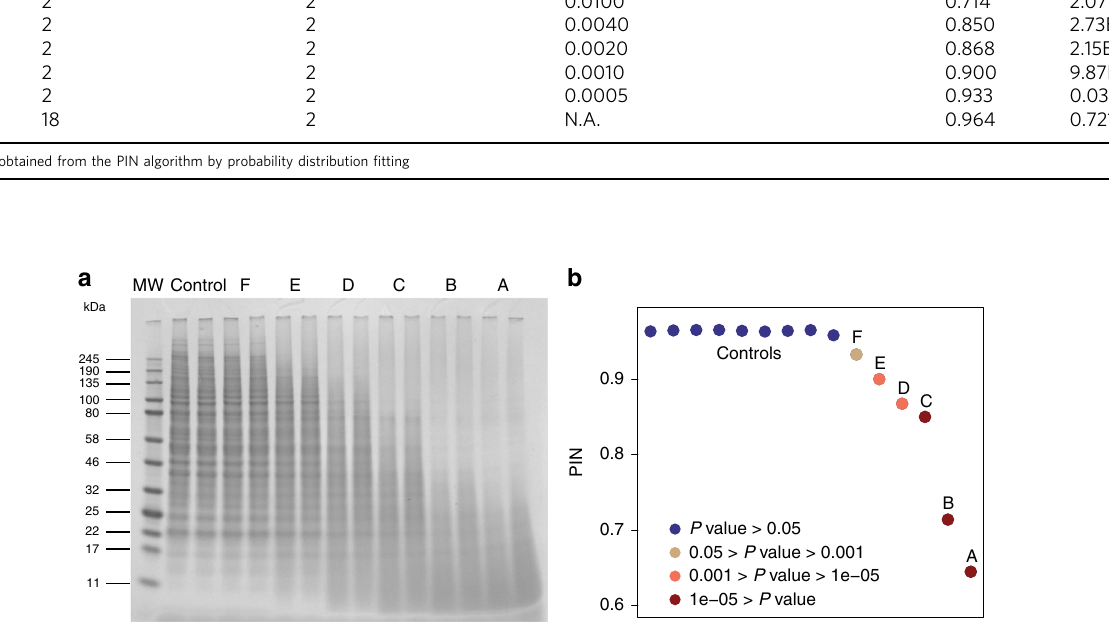
Table 1 The overall experimental design and results of the benchmarking study Sample